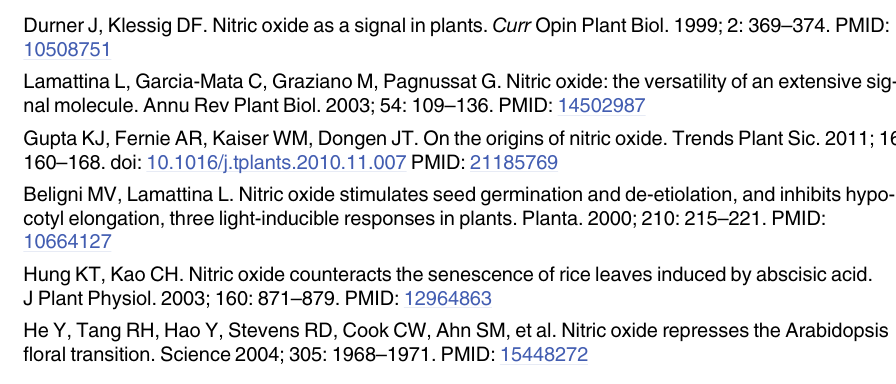
S1 Fig. Effect of high nitrate on P. patens protonema growth and NR activity. The effect of high nitrate in growth A) and NR activity B) was analyzed in plants that grew for seven days in Knop media alone or with 8.4 mM Ca(NO3)2, supplemented or not with 30 μ M sodium tung- state. Relative growth rate was measured according the formula: ( ln a are the plant area at day 7 and at day 0, respectively. t is the time growth in days = 7. Data a 0 are mean of three independent experiments. Data were analyzed by one-way ANOVA and Tukey ’ s multiple comparison test ( n = 56 in panel A and n = 7 – 9 in panel B). Different letters indicate a statistically significant difference ( P < 0.05). Error bars denote